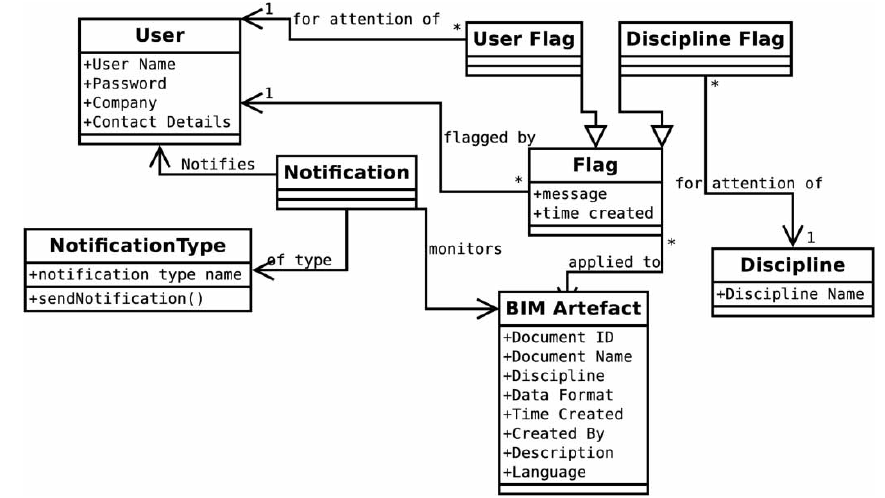
Fig. 8. Change notification and version propagation